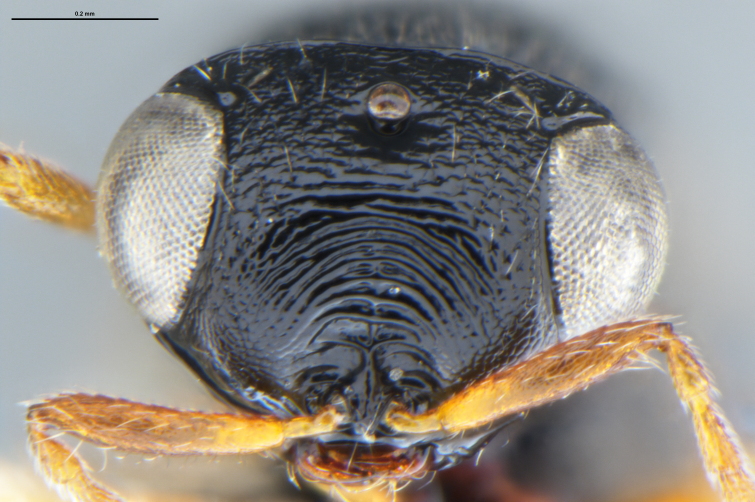
head, anterior view